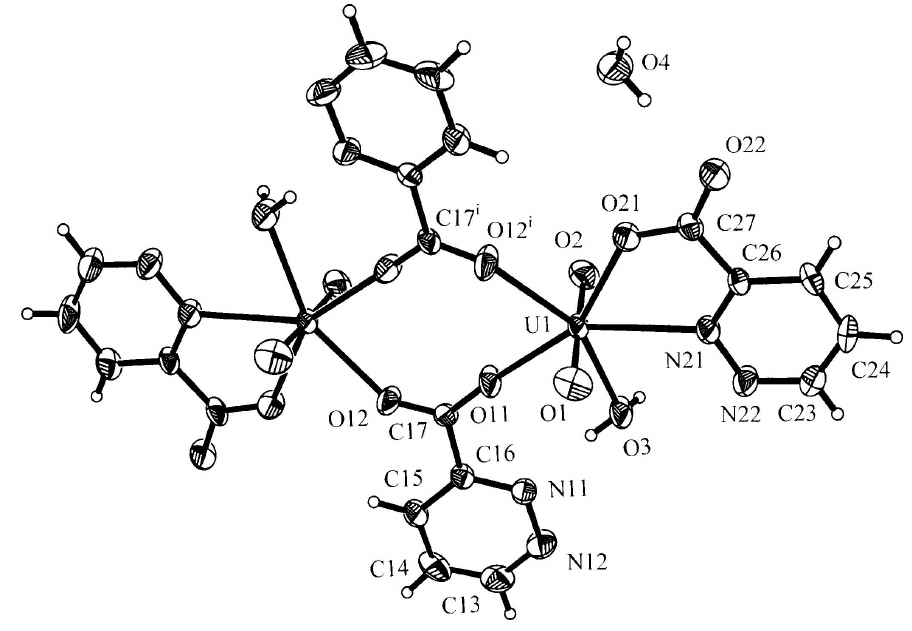
Figure 1 View a dimer of title compound with the atom labelling scheme. Displacement ellipsoids are drawn at 50% probability level. H atoms are presented as a small spheres of arbitrary radius. Symmetry code: ( i )- x +1, y , - z +1/2.